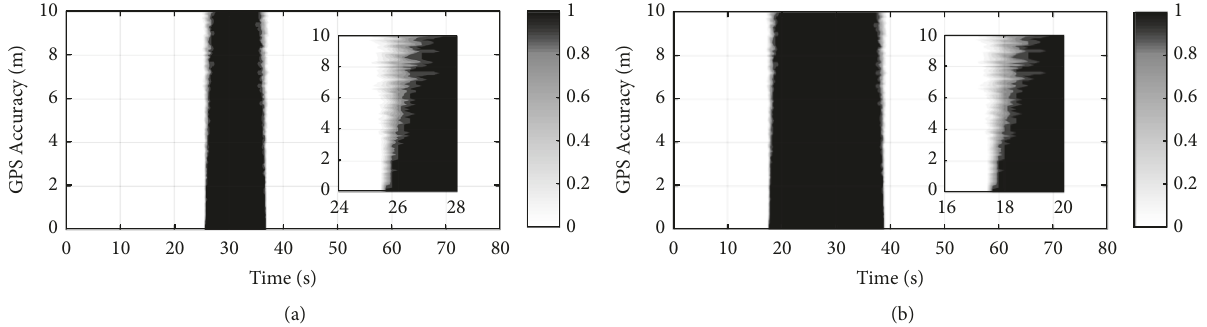
Figure 7: Crossing risk probability for different GPS accuracy. (a) No-control scenario. (b) Control scenario.